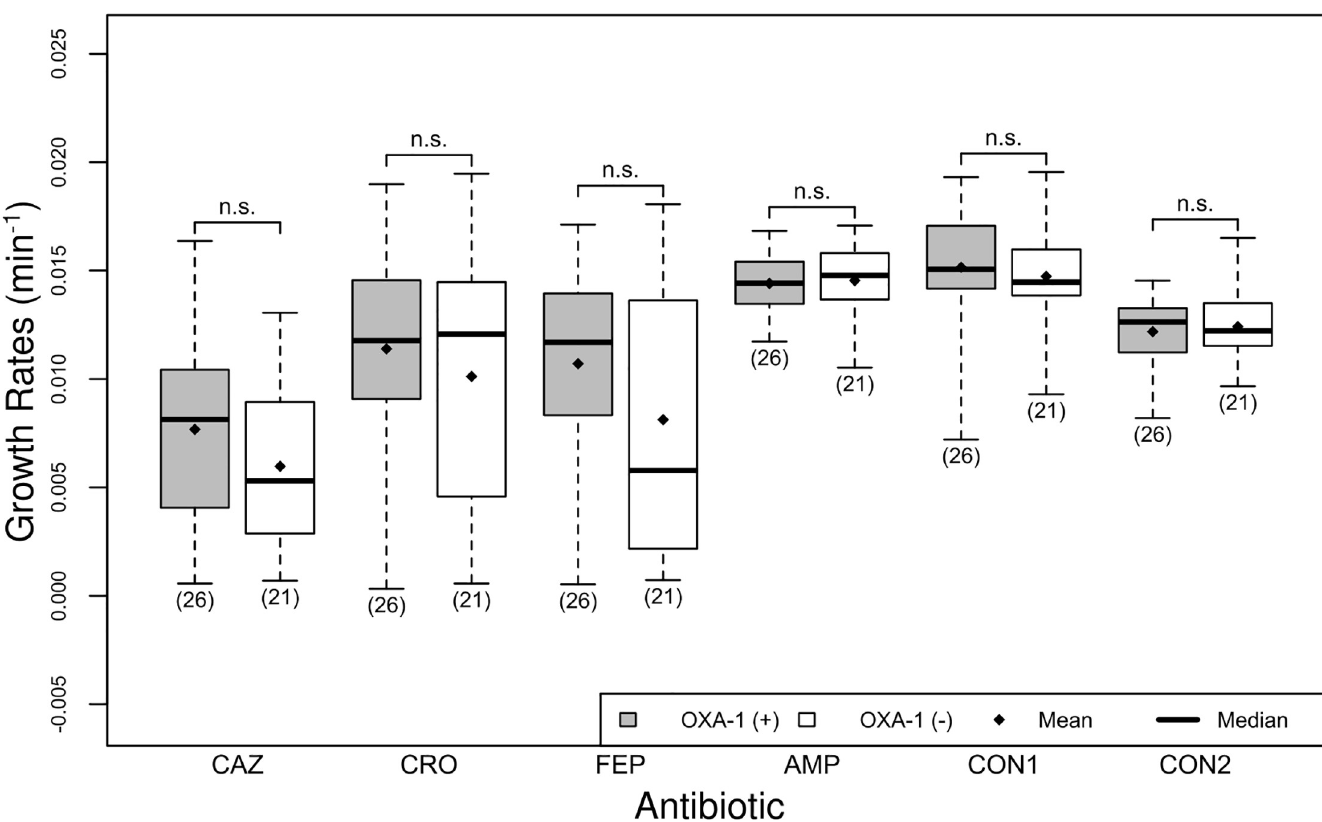
Fig 5. The presence of OXA-1 does not affect isolate growth rates. There are two boxplots per antibiotic, the first (gray) shows the distribution of growth rates for isolates that have the OXA-1 gene, labeled OXA-1 gene (+), and the second (white) shows the distribution of growth rates for isolates that do not have the OXA-1 gene, labeled OXA-1 (-). See Fig 1 for interpretation of